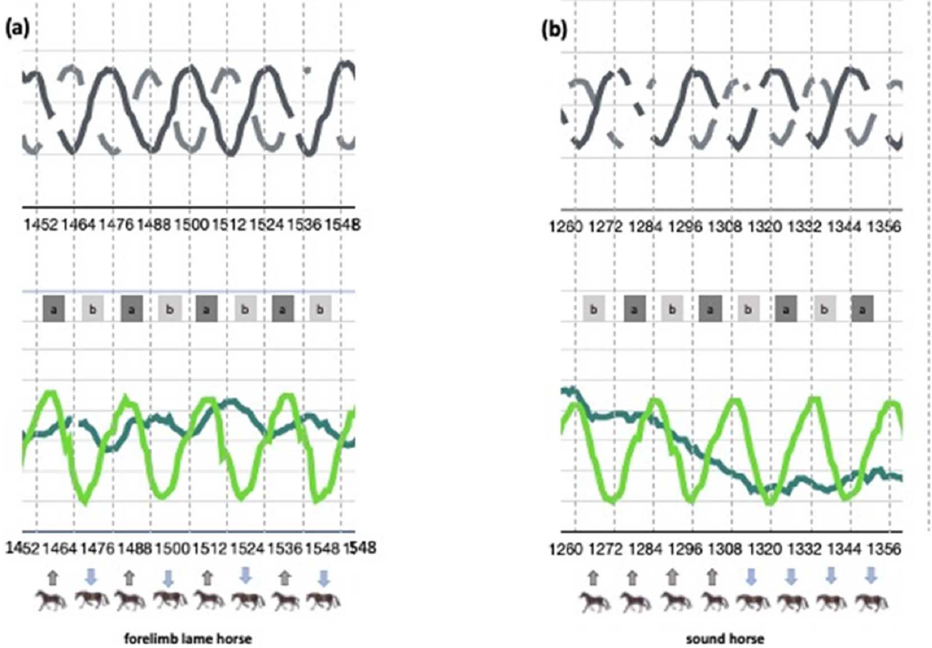
Figure 2. Graphical presentation of forelimb lameness in one representative horse (no. 11) ( a ) com- pared to a representative non-lame horse (no. 7), ( b ) on a left circle. a in the square = stance phase left forelimb, b in the square = stance phase right forelimb. Grey arrows indicate upward head movement, blue arrows indicate downward head movement. Upper graphs: grey lines show movements of left and right forelimb, with maximum values identifying the protracted foreleg = beginning of the stance phase (stride identification). Lower graphs: dark green line shows head movement, light green line shows movement of left forelimb; the numbers represent the frames of the video in the extracted sequence.